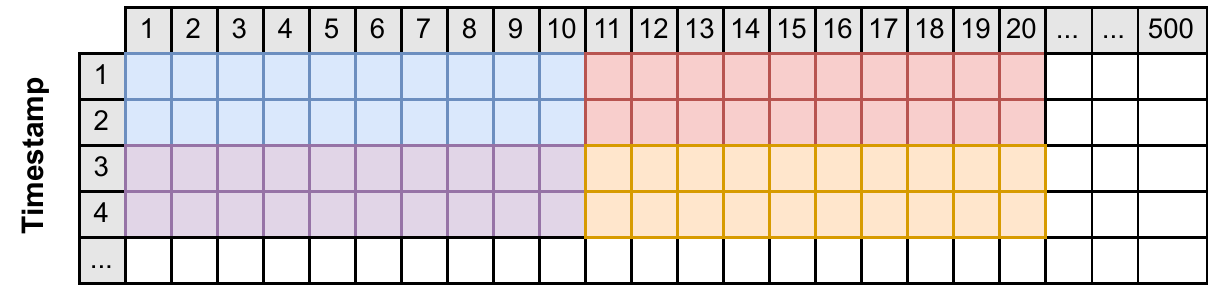
Figure 13. Schematic representation of the 2:50 × 10 setup. Table 2. The different operations to be performed and their identification as a combination of the row size and the simultaneous